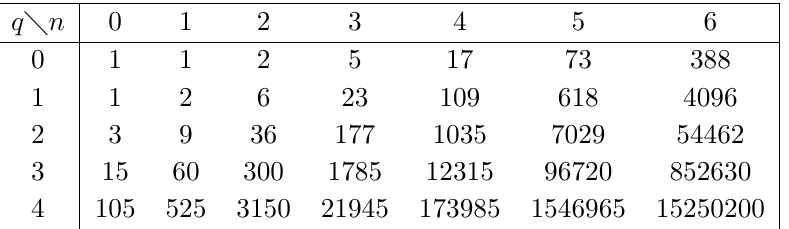
Table 4 . Number of distinct dipole graphs for q quark-antiquark pairs and n gluons, allowing any number of self-connected gluons (see eq.